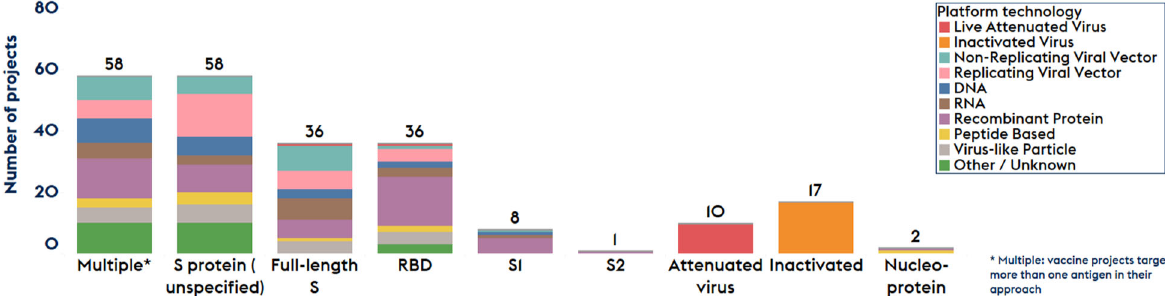
Fig. 1 Landscape of target antigens included in COVID-19 vaccine development. The number of projects is shown for each target antigen. Different platform technologies being used are coded with different colors as de fi ned in the